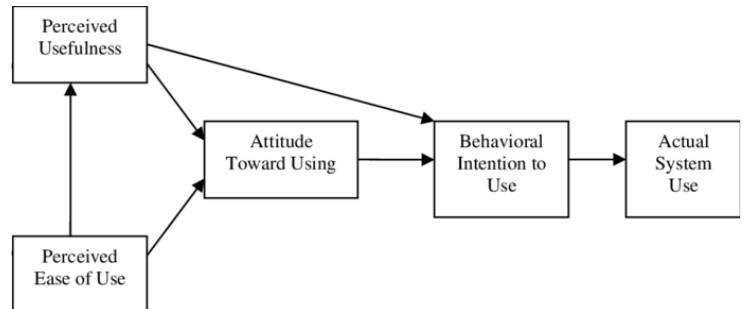
Figure 1. TAM model.